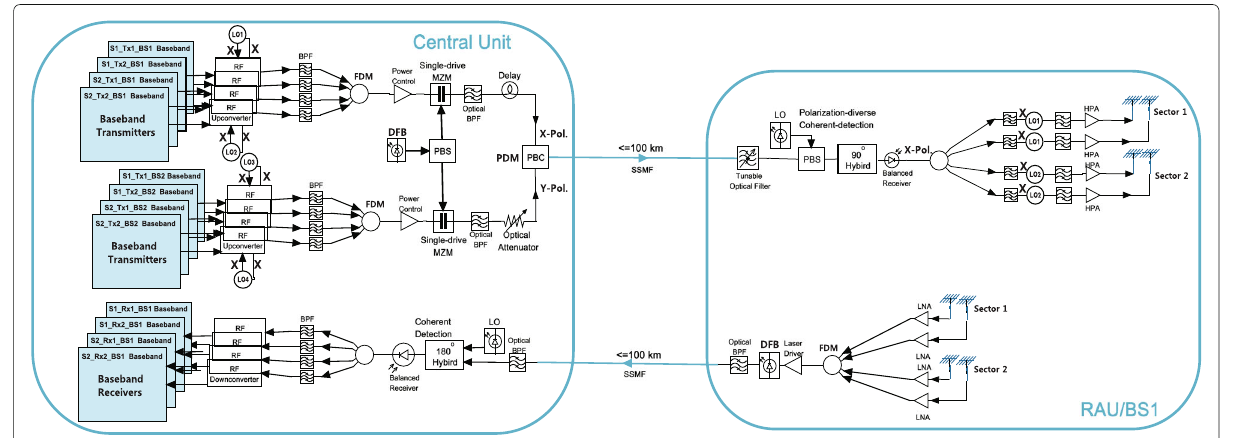
Fig. 2 Proposed RoF transmission system for next-generation C-RAN